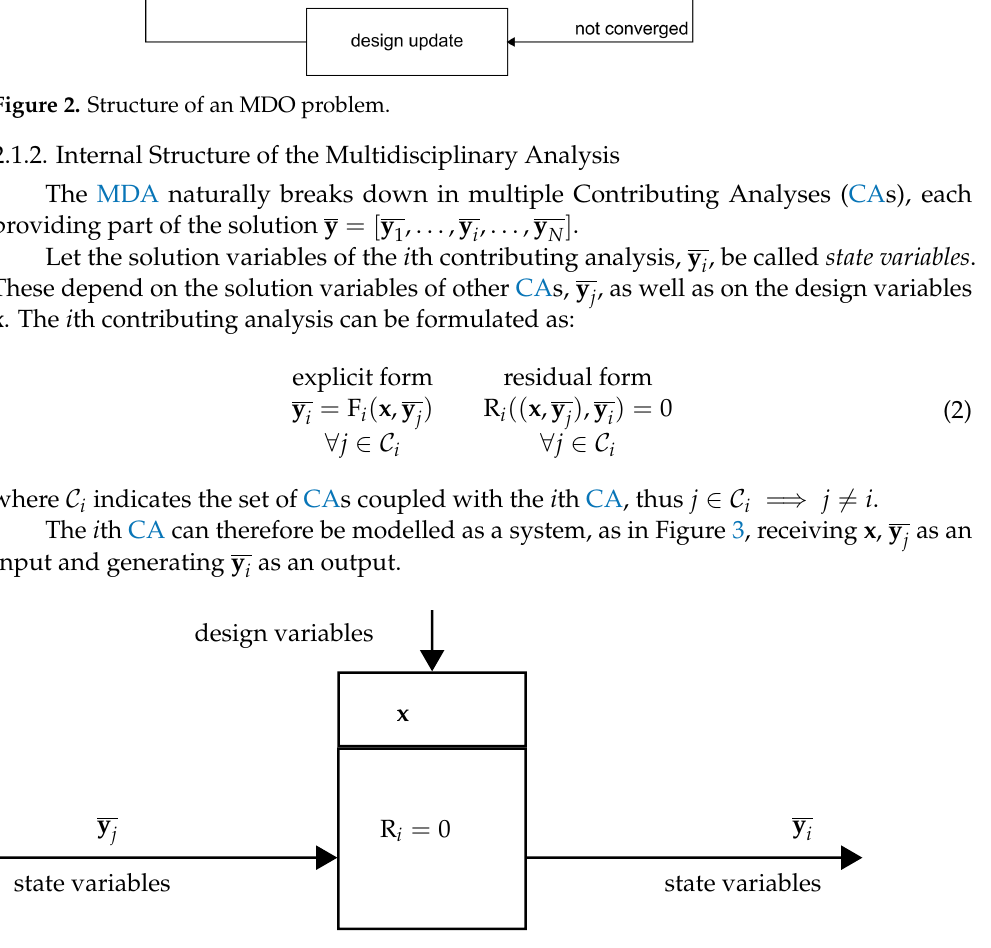
Figure 3. A contributing analysis ( i ) modelled as a system, receiving input from another CA ( j